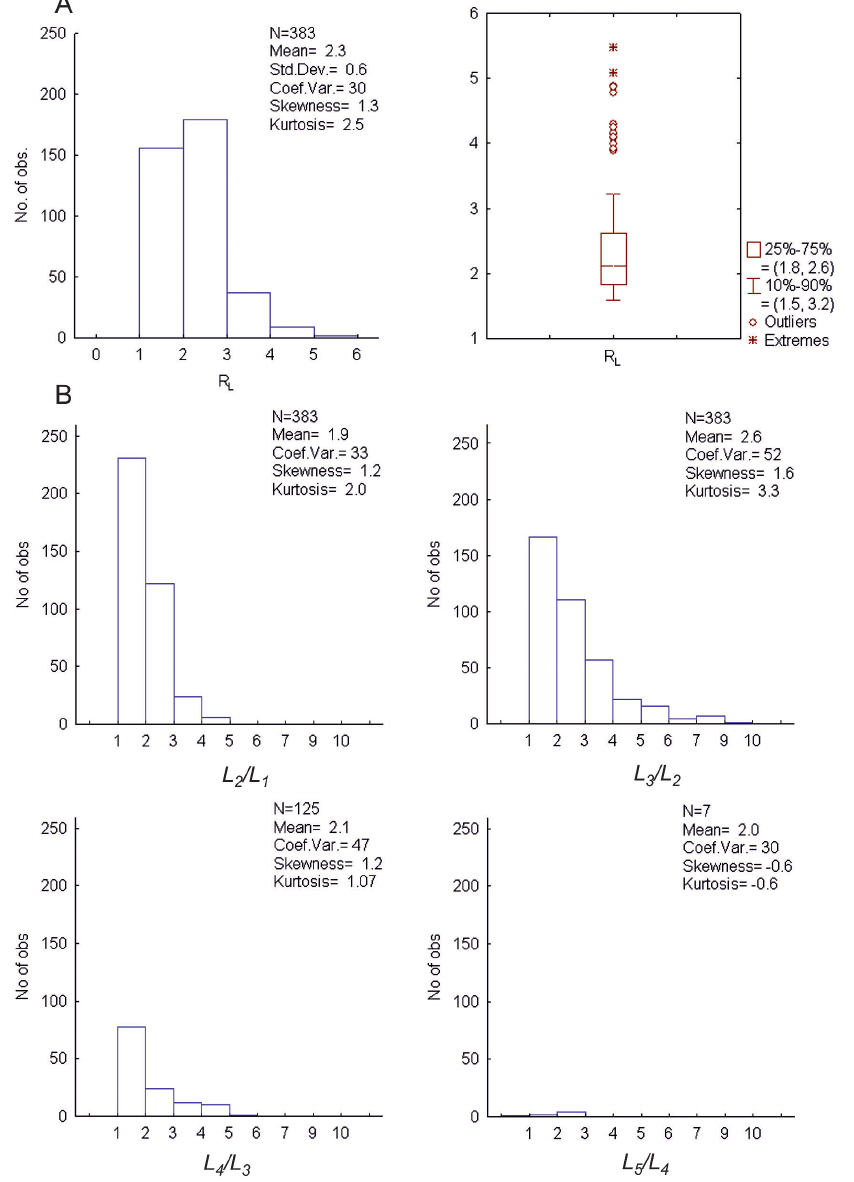
Fig. 3. The length ratio (R ) in the investigated catchments – A, the growth rate of the length ratio – B. Labeled like fig. L